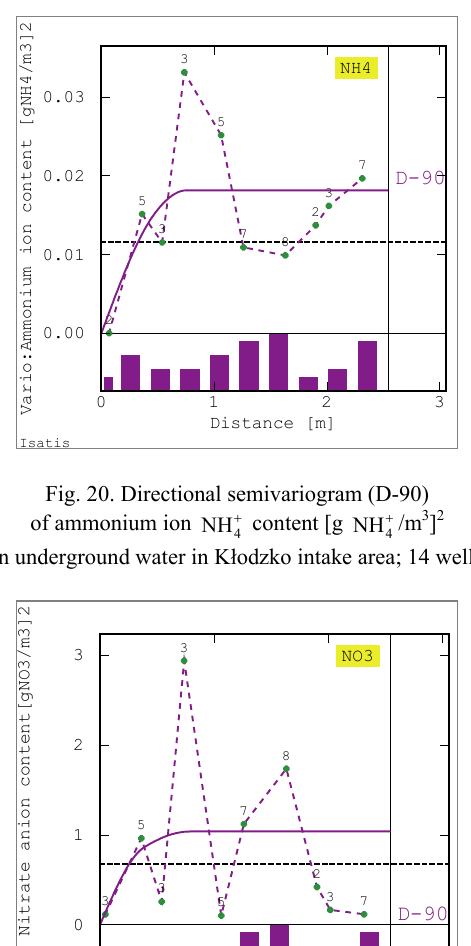
Fig. 17. Directional semivariogram (D-90) of iron Fe ++ content [g Fe ++ /m 3 ] 2 in underground water in Kłodzko intake area; 14 wells + 3 piezometers